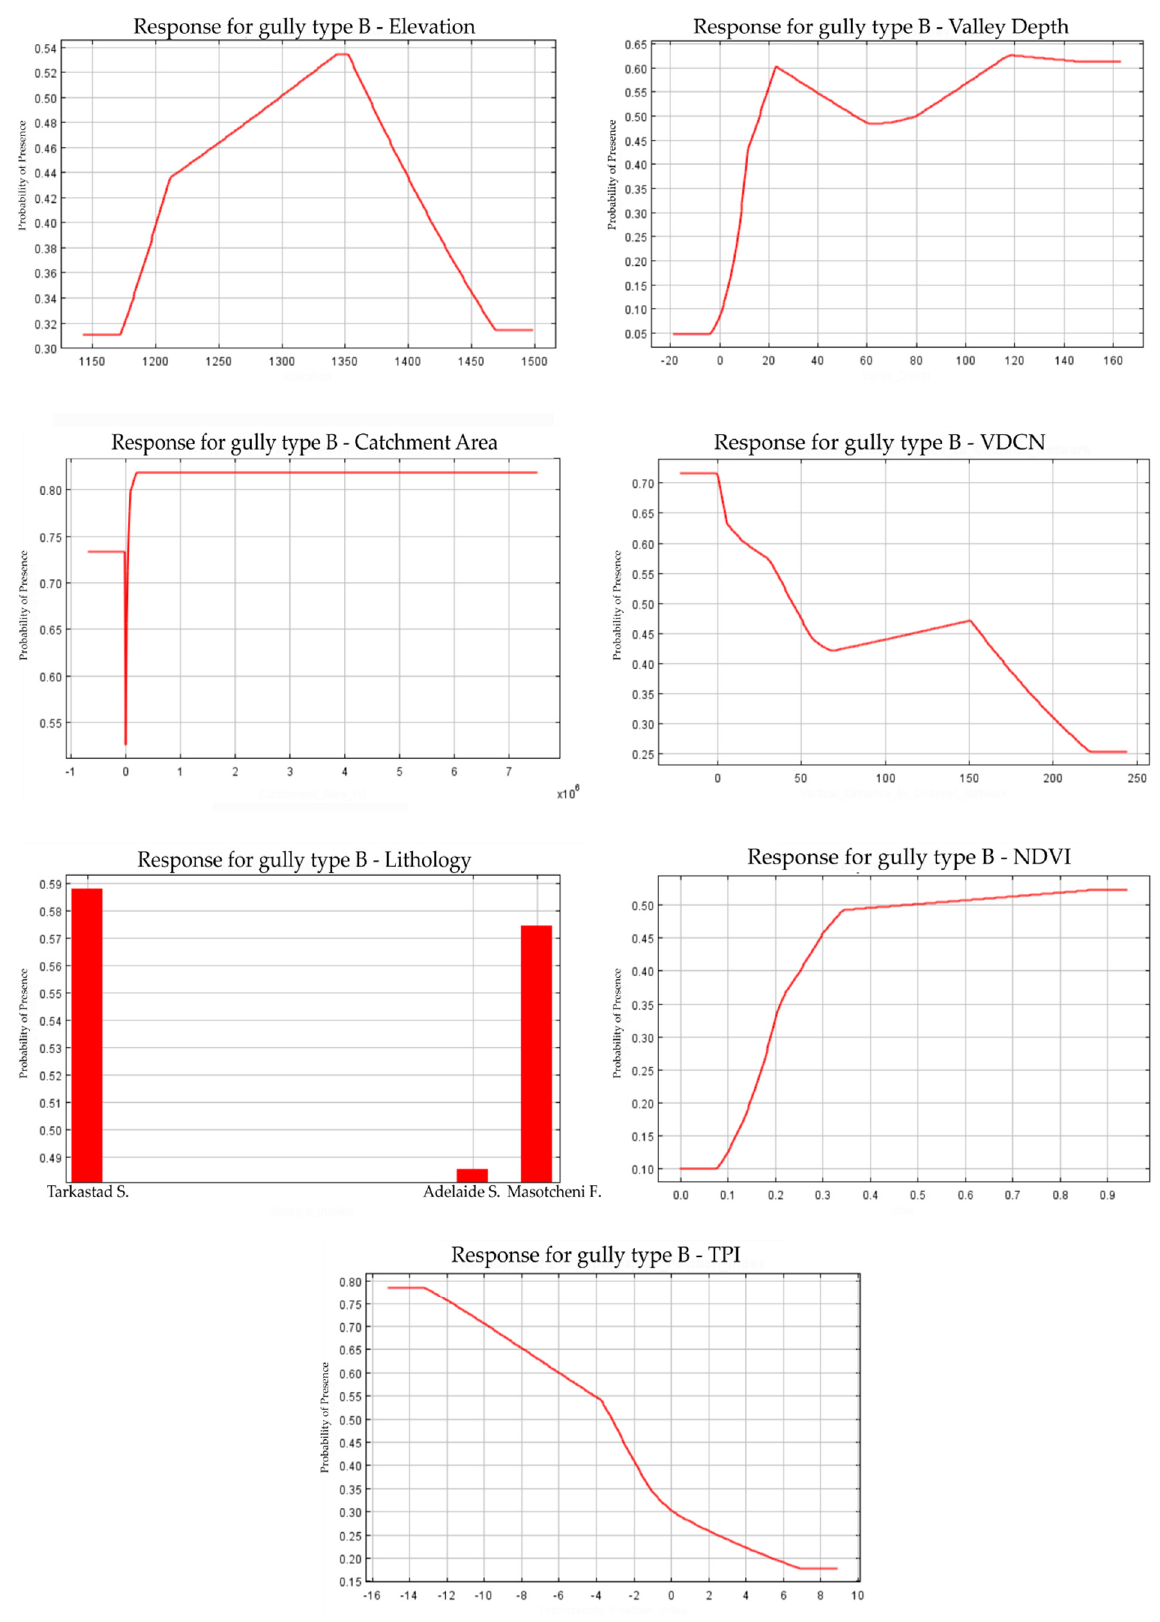
Figure 6. Variable importance for gully type B.